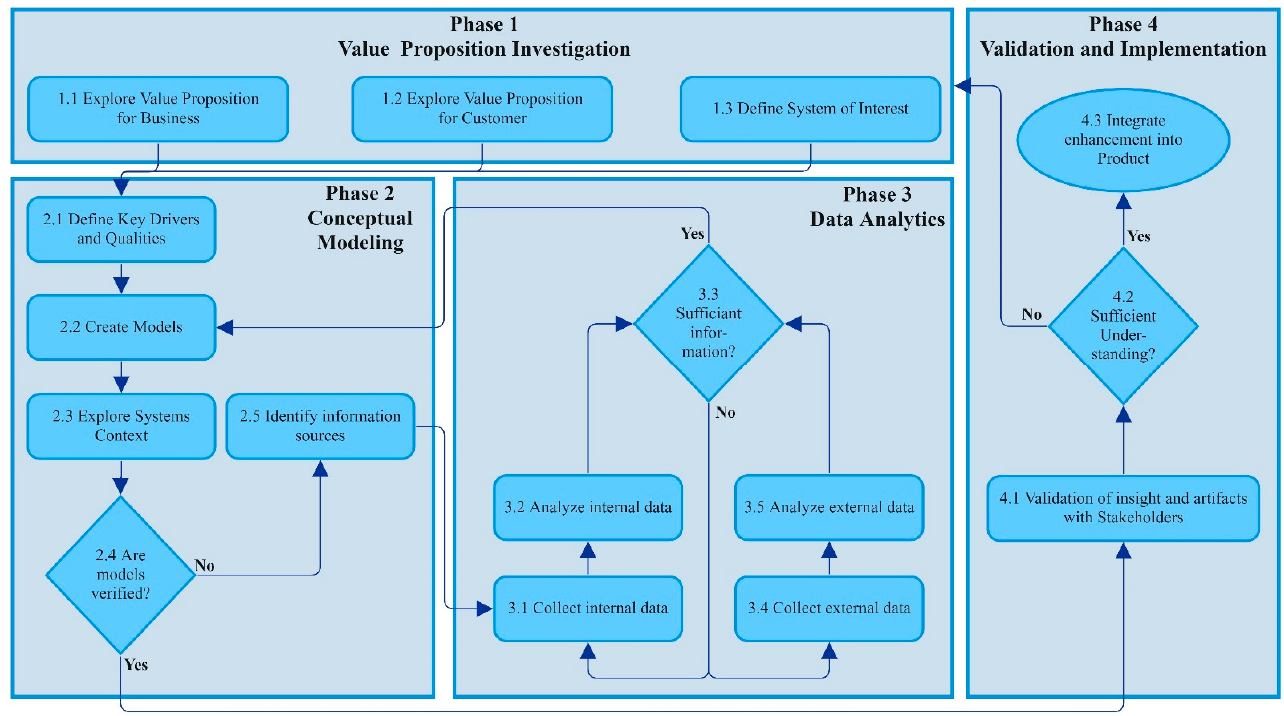
Figure 4. Data Sensemaking Framework.